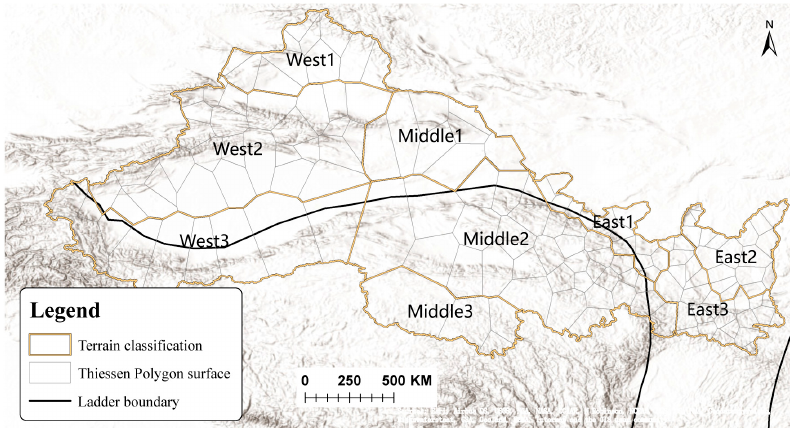
Figure 4. Results of the large-area division of the northwest region.